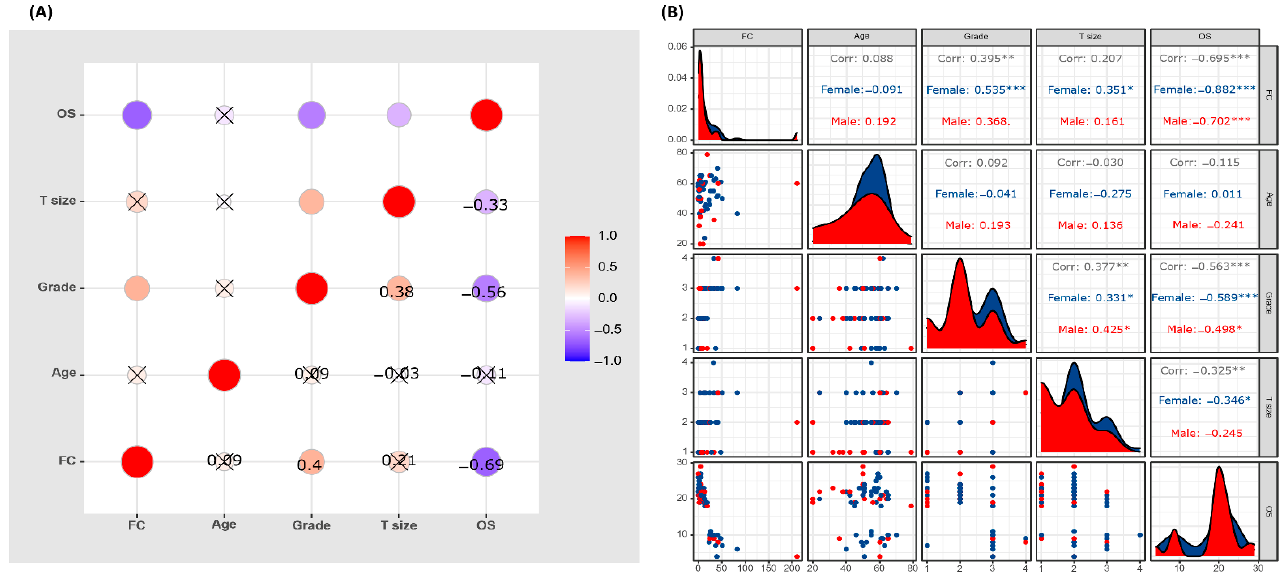
Figure 4. Correlation matrix of HSP70 expression levels and clinicopathological characteristics of renal cell carcinoma (RCC). Correlation plot showing the relation between HSP70 expression and the clinicopathological characteristics in RCC patients. OS: overall survival, T: tumor size, FC: fold change. Pearson correlation analysis was employed. ( A ) Overall analysis. ( B ) Stratification by sex. Male in red and female in blue. * p < 0.05, ** p < 0.01, *** p < 0.001.